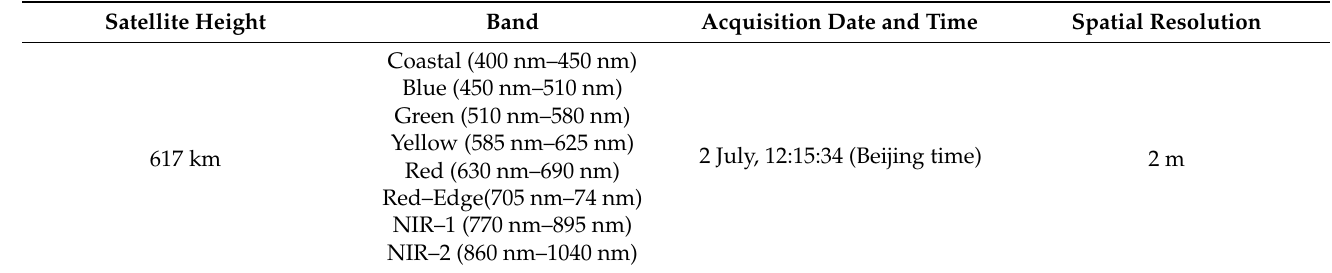
Table 3. The introduction of World-View